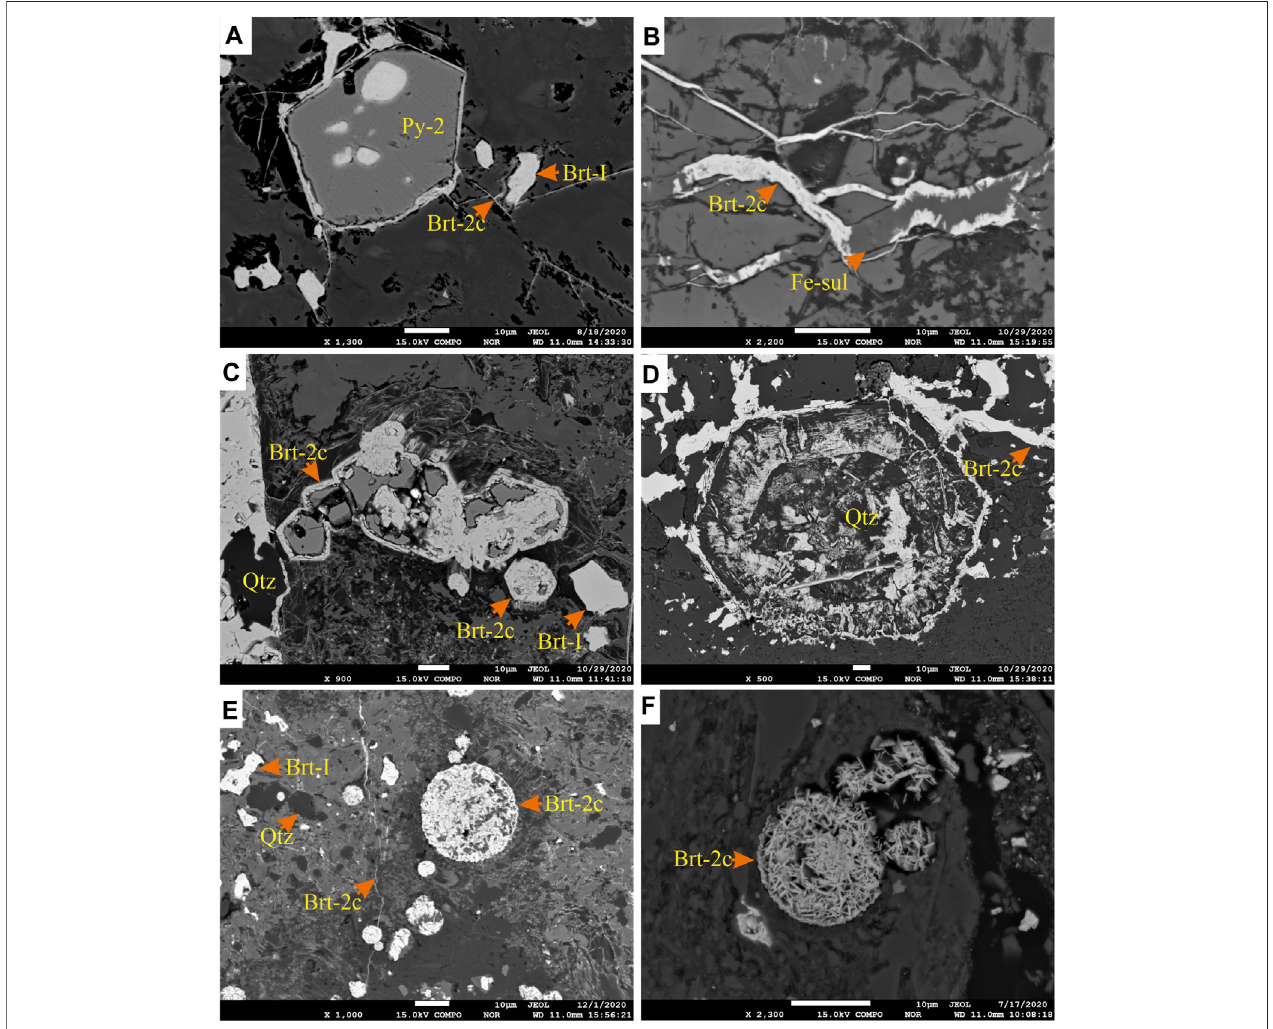
FIGURE10|(A) BSEimageofPy-2pyritecrystal withpores fi lledbybarite.Bariteveins(Brt-2c) areobservedtorim thecrystal. (B) Barite and iron-sulfatevein that appeartorimearlierformedminerals,asseeninimage (A) . (C) BSEimageoftheprogressivereplacementofpyrite(Py-2)bybarite(Brt-2c),thatsubsequentlyreplacethe pyrite grain but retaining the morphology of the mineral. (D) acicular barite pseudomorph retaining the replaced euhedral quartz habit. (E) BSE image of barite vein (Brt- 2c) crosscutting and replacing pyrite framboids (Py-1). (F) Py-1 framboids completely replaced by euhedral microcrystals of barite, suggested to have progressed from the process observed in images (C) and (E)